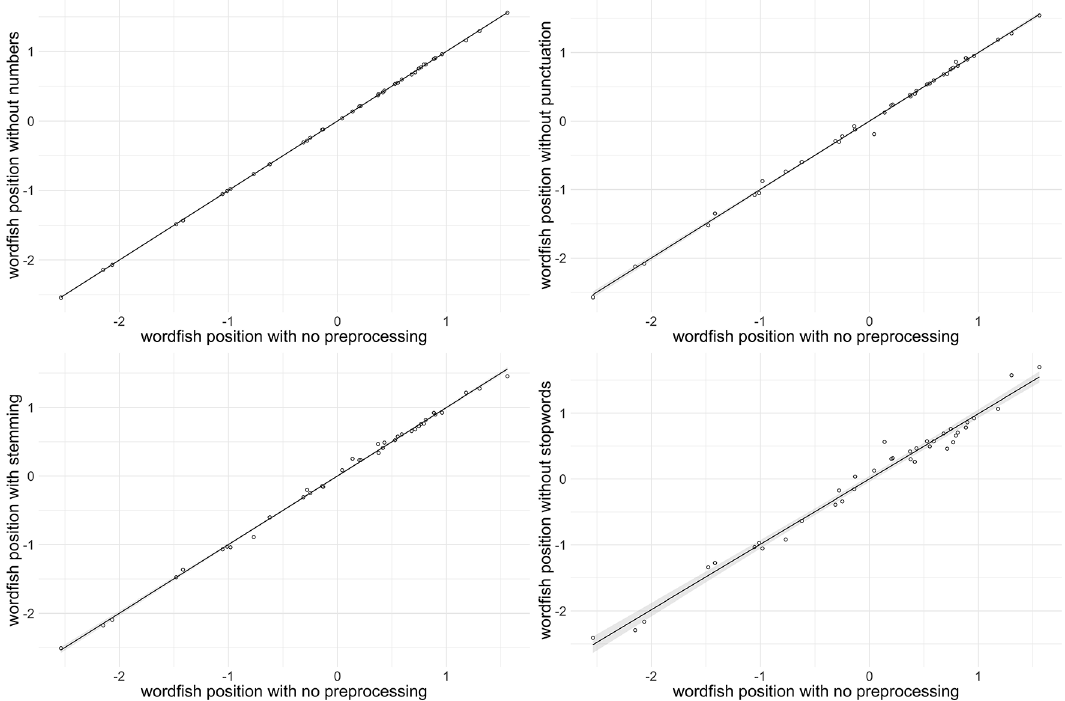
Figure 3. Wordfish estimates based on speeches by politicians in the European Union, with and without four preprocessing steps applied to the